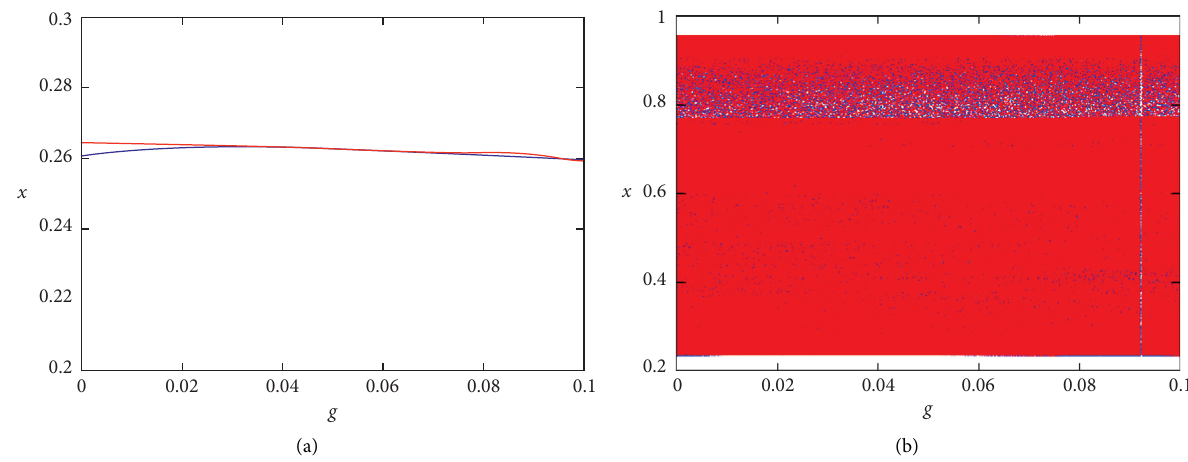
Figure 12: Effect of β on bifurcation diagram and its corresponding Lyapunov exponent of nonlinear chemical reaction with ω � 0.0481, Ω � 80 ω , α � 0.0413, and f � 0.002: (a) β � 0.04; (b) β � 0.08. Bifurcation diagrams and its corresponding Lyapunov exponent are obtained by scanning the parameter g upwards (blue) and downwards